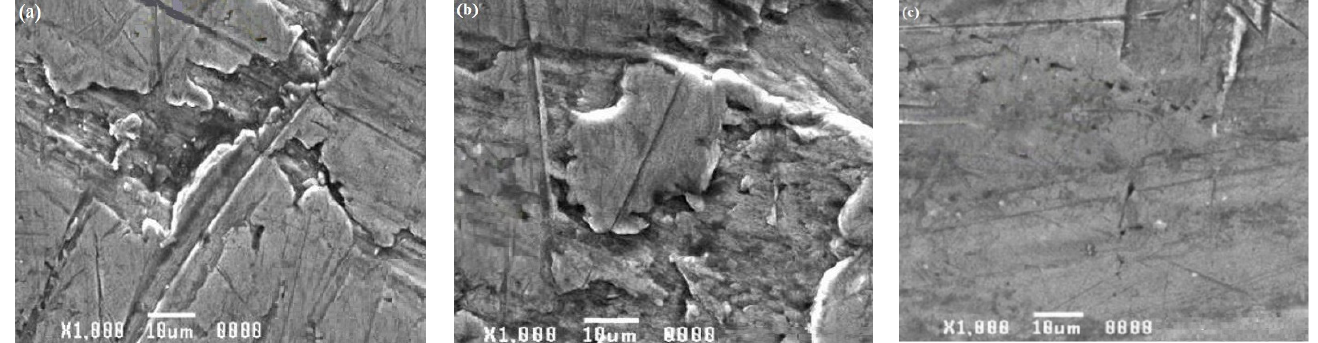
Figure 14. SEM images of ( a ) AA6061, ( b ) AA8011, ( c ) and weld region specimens after submersion testing in HCl.